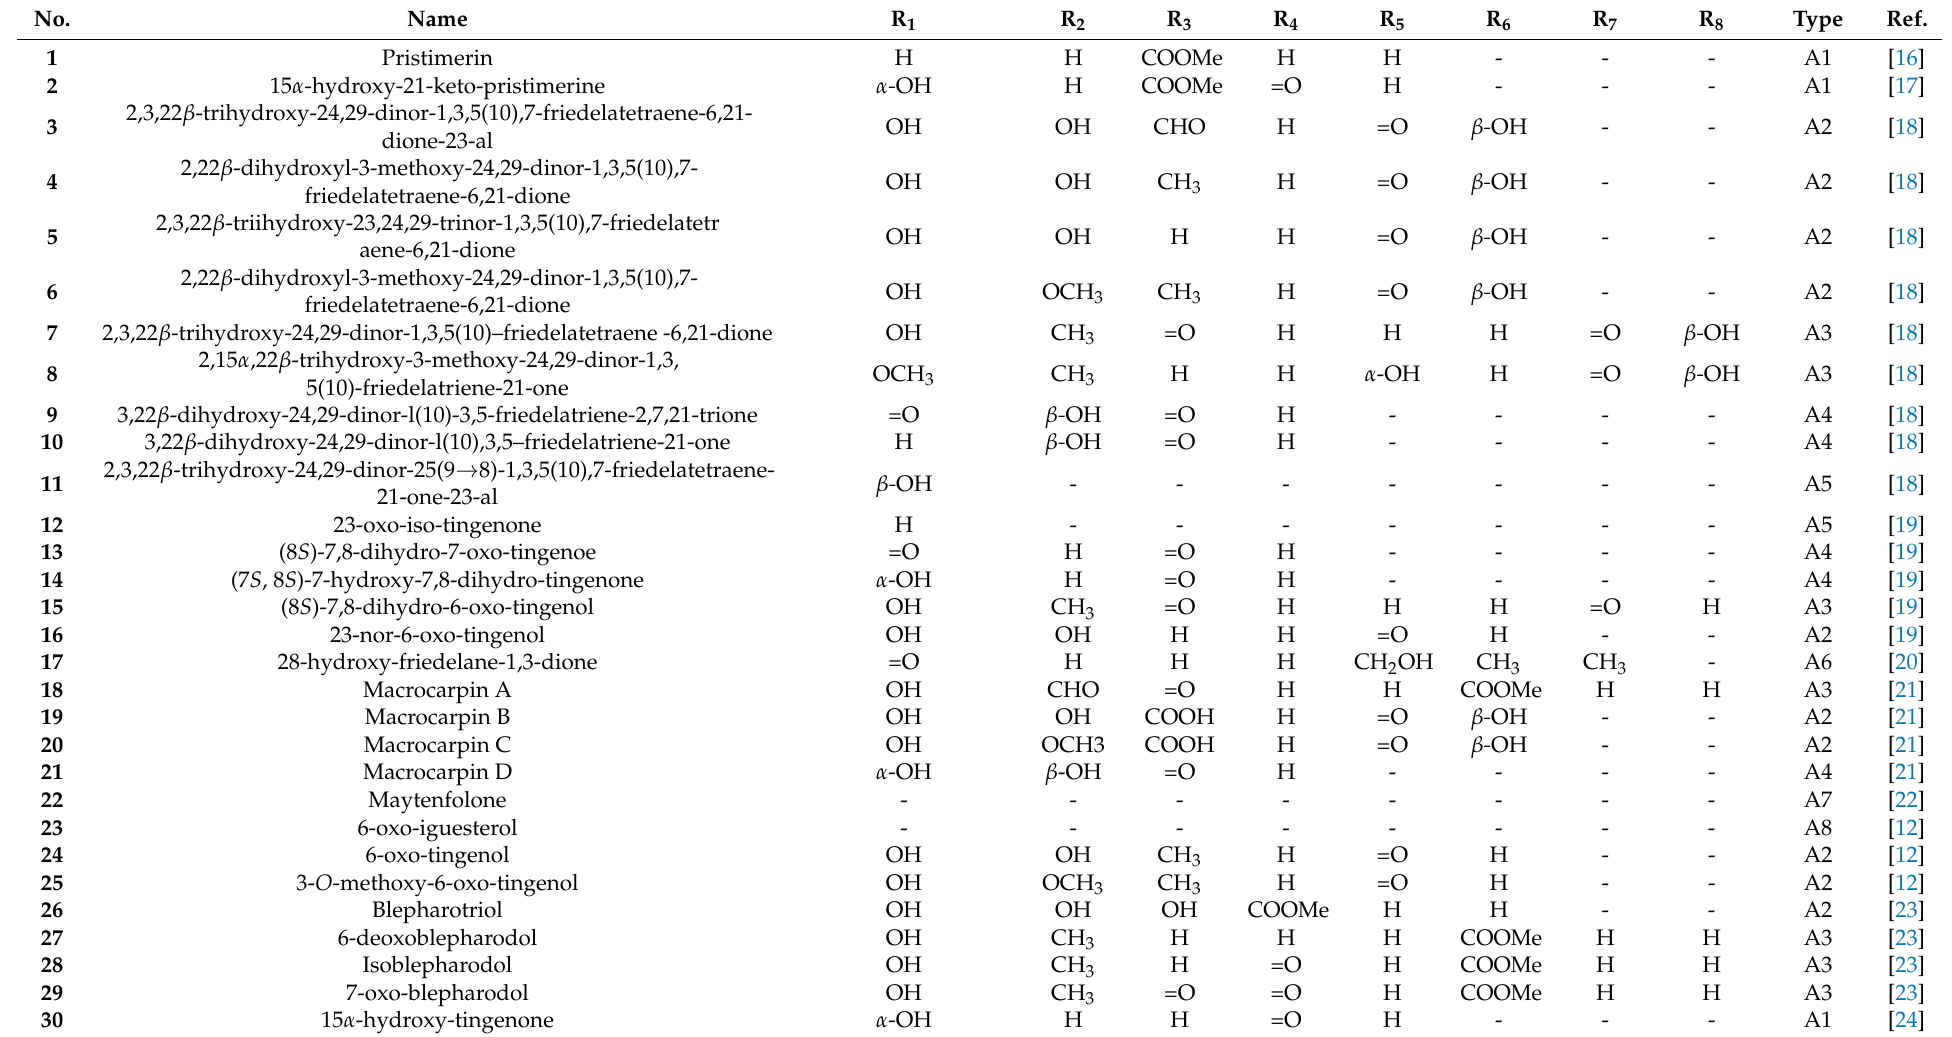
Table 1. The friedelane triterpenes isolated from Maytenus